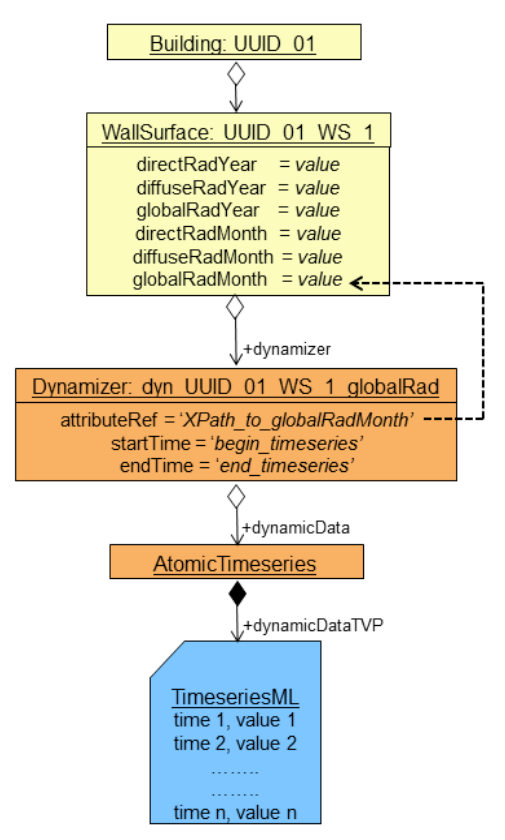
Figure 3. An instance diagram of representing the time- dependent solar potential simulation results using